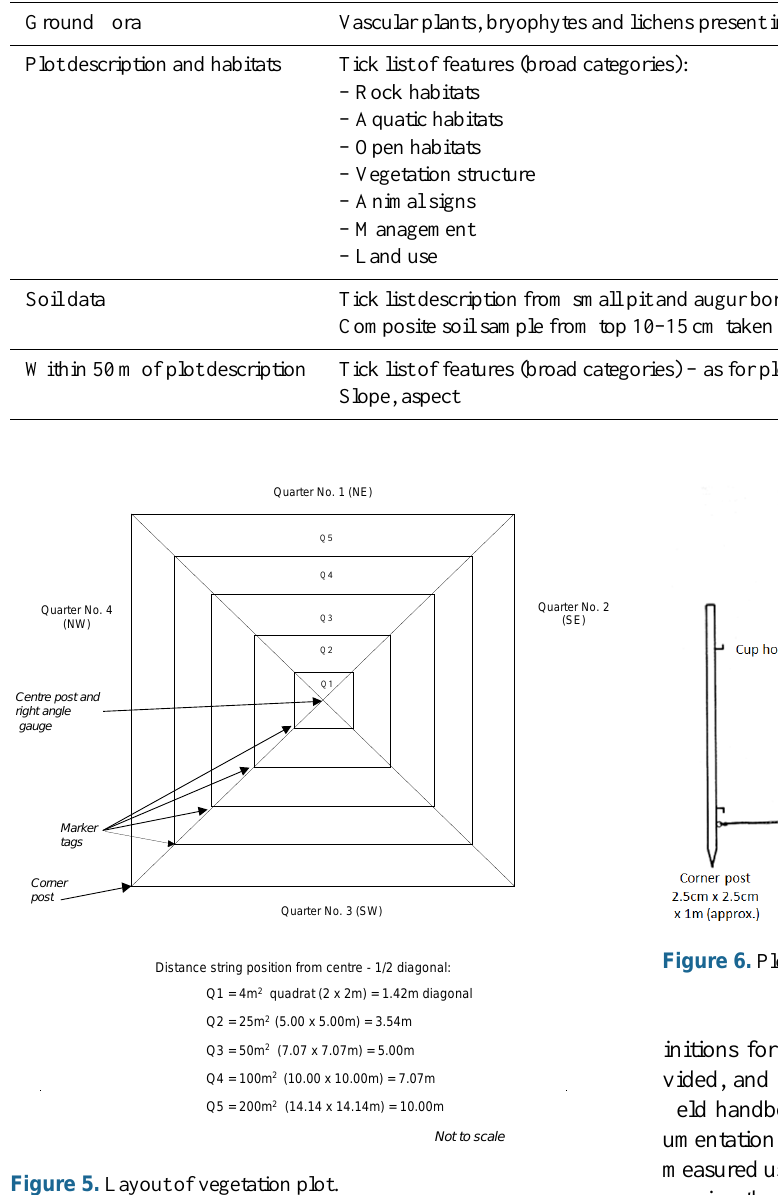
Figure 5. Layout of vegetation plot.